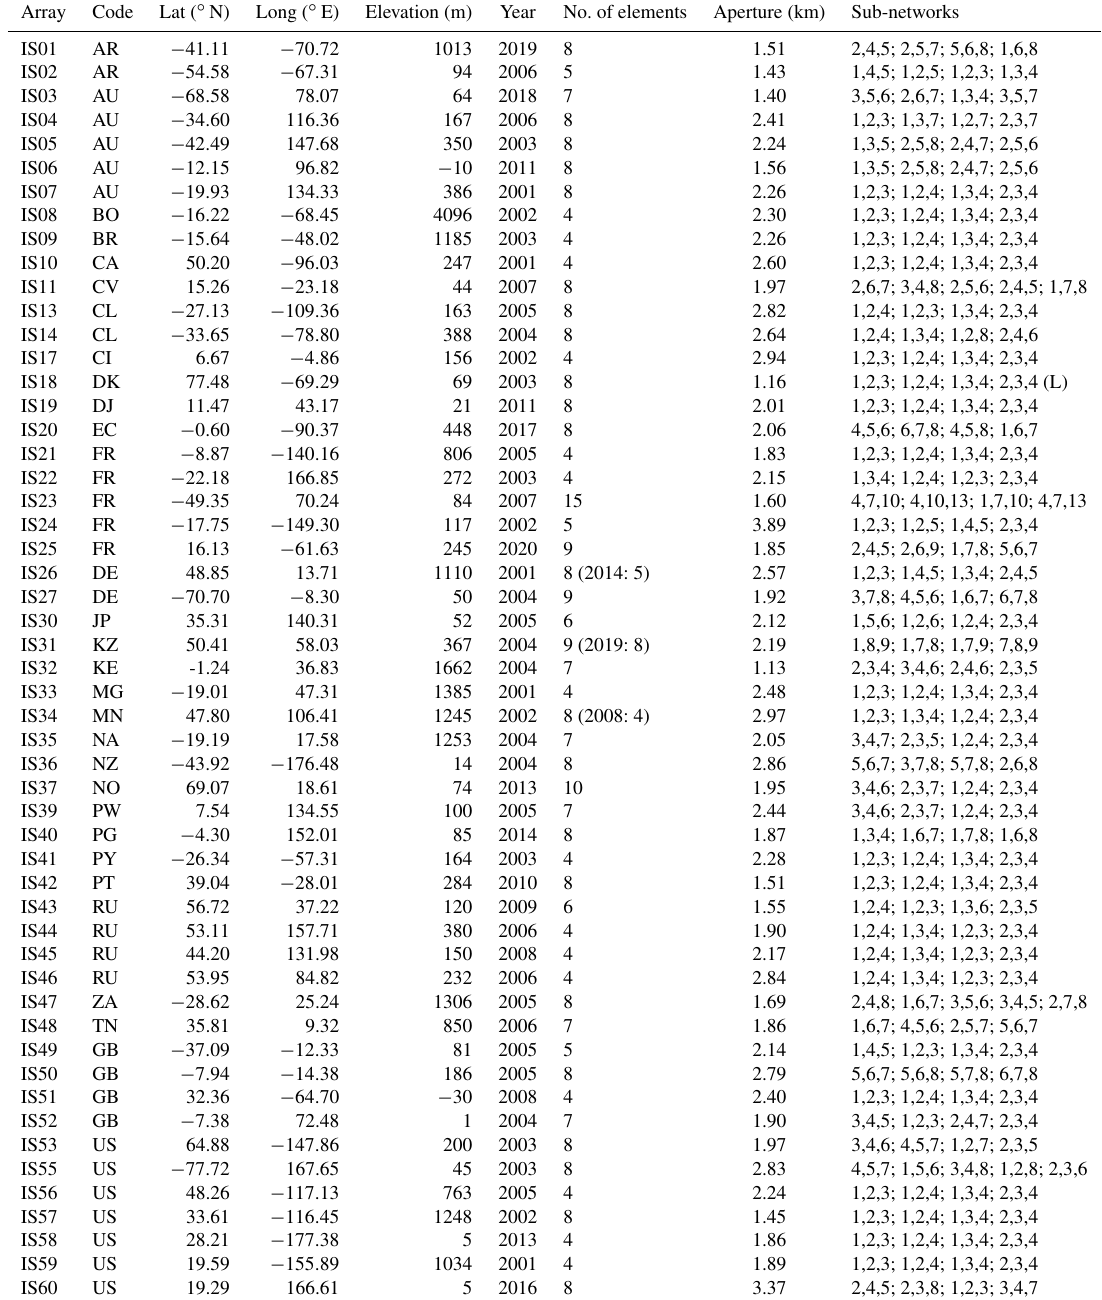
Table A1. IMS infrasound array properties, certification year (see Fig. 1), and selected sub-networks for the PMCC processing. If elements were added to the array, then the year of this modification (revalidation) and the previous number of array elements are indicated in parenthe- ses behind the latest number of elements. These changes did not alter the apertures because the new sensors were installed within the existing arrays. The sub-network information contains triplets of sensors numbers, referring to the latest channel numbering (e.g., L1, ... L4, ... or H1, ... H8, ...). If two types (H and L) are still defined (IS18 was homogenized to H in 2016, but the name was not changed), then